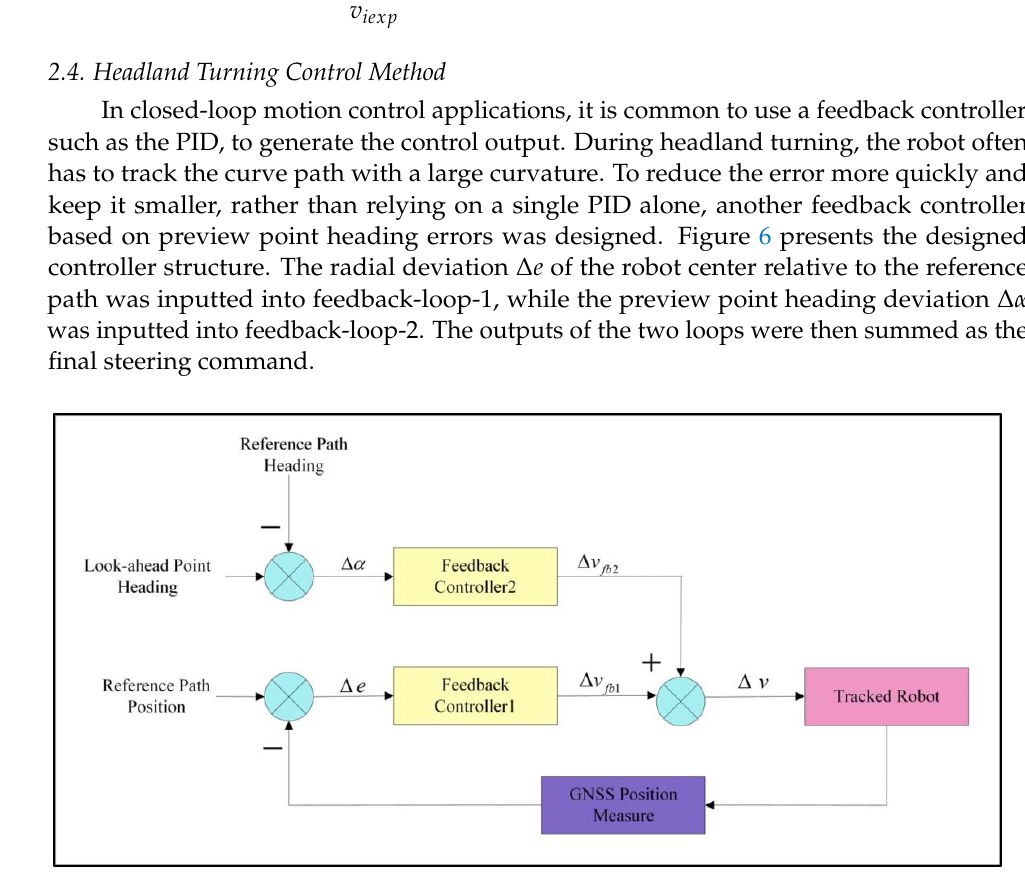
Figure 6. Turning controller structure diagram.